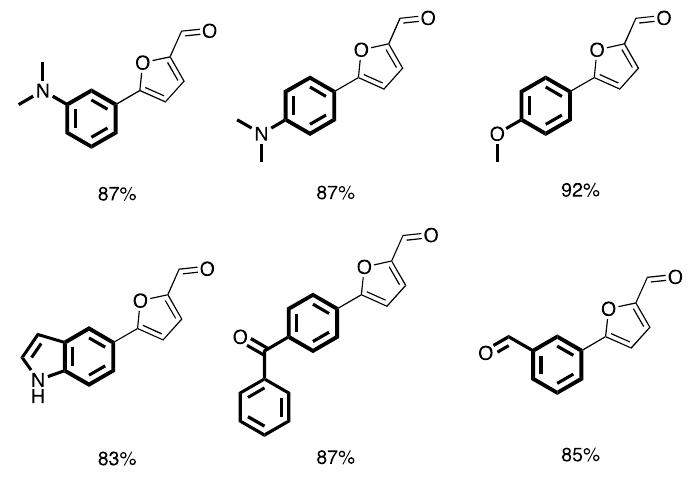
Figure 8. Substrate scope of continuous flow Suzuki–Miyaura cross-coupling sequence using PdCl 2 (PPh 3 ) 2 DVB catalyst.